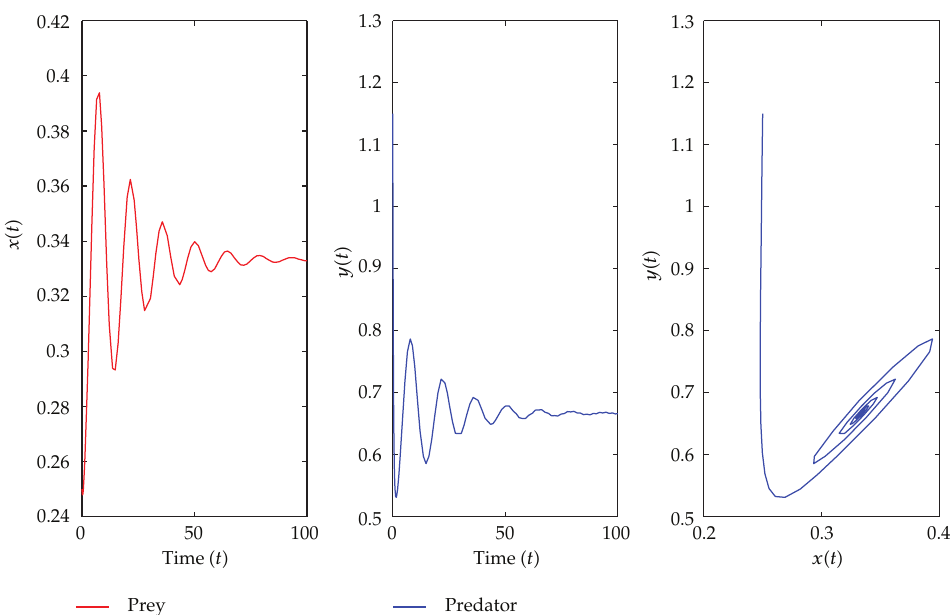
Figure 1: E (cid:7) 0 . 3333 , 0 . 6666 (cid:8) is asymptotically stable when τ 1 (cid:6) 3 . 15 < τ 10 (cid:6) 3 . 7457 with initial value 0.25,